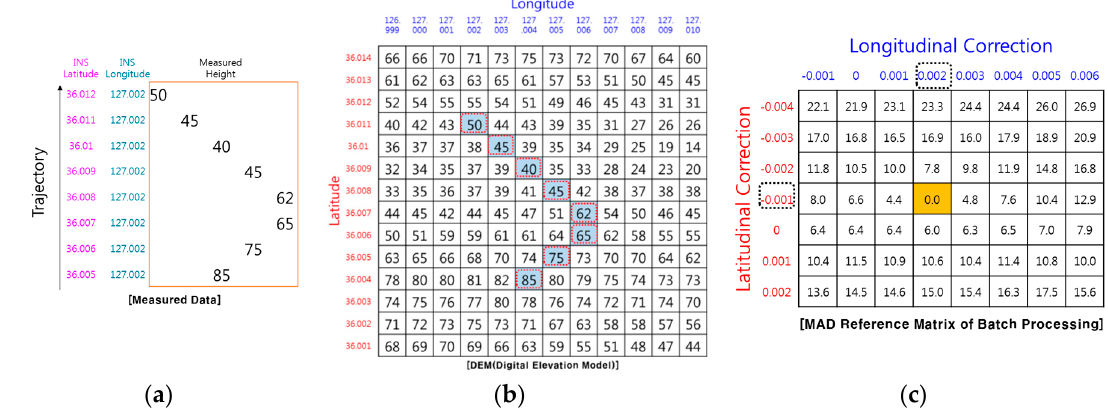
Figure 6. Example of TRN using IRA: ( a ) Measured terrain profile; ( b ) DEM; ( c ) position correction value. Comparing DEM and the relative position up to the closest point, correction values of − 0.001° in latitude direction and +0.002° in longitude direction can be obtained. The correction values are the same as those of the ideal TRN with RA, shown in Figure 2.